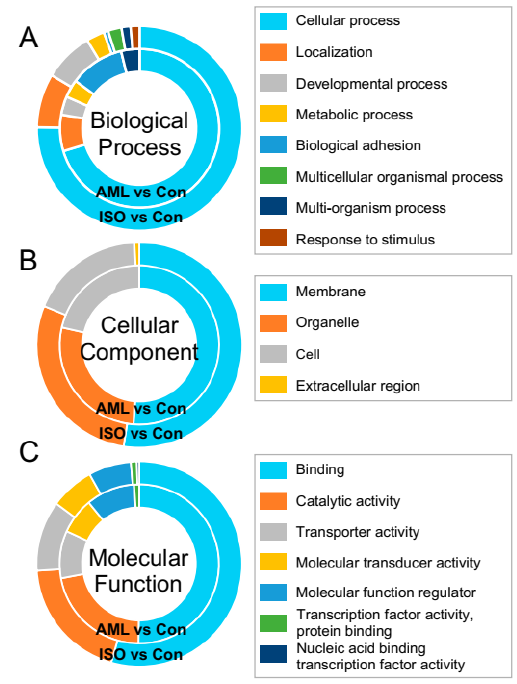
Figure 4. Gene ontology (GO) functional classification of differentially expressed genes. Comparison of GO in terms of biological processes ( A ), cellular components ( B ), and molecular function ( C ) that were enriched in the AML- and ISO-exposed embryos of zebrafish. Composition of each GO term is represented as a